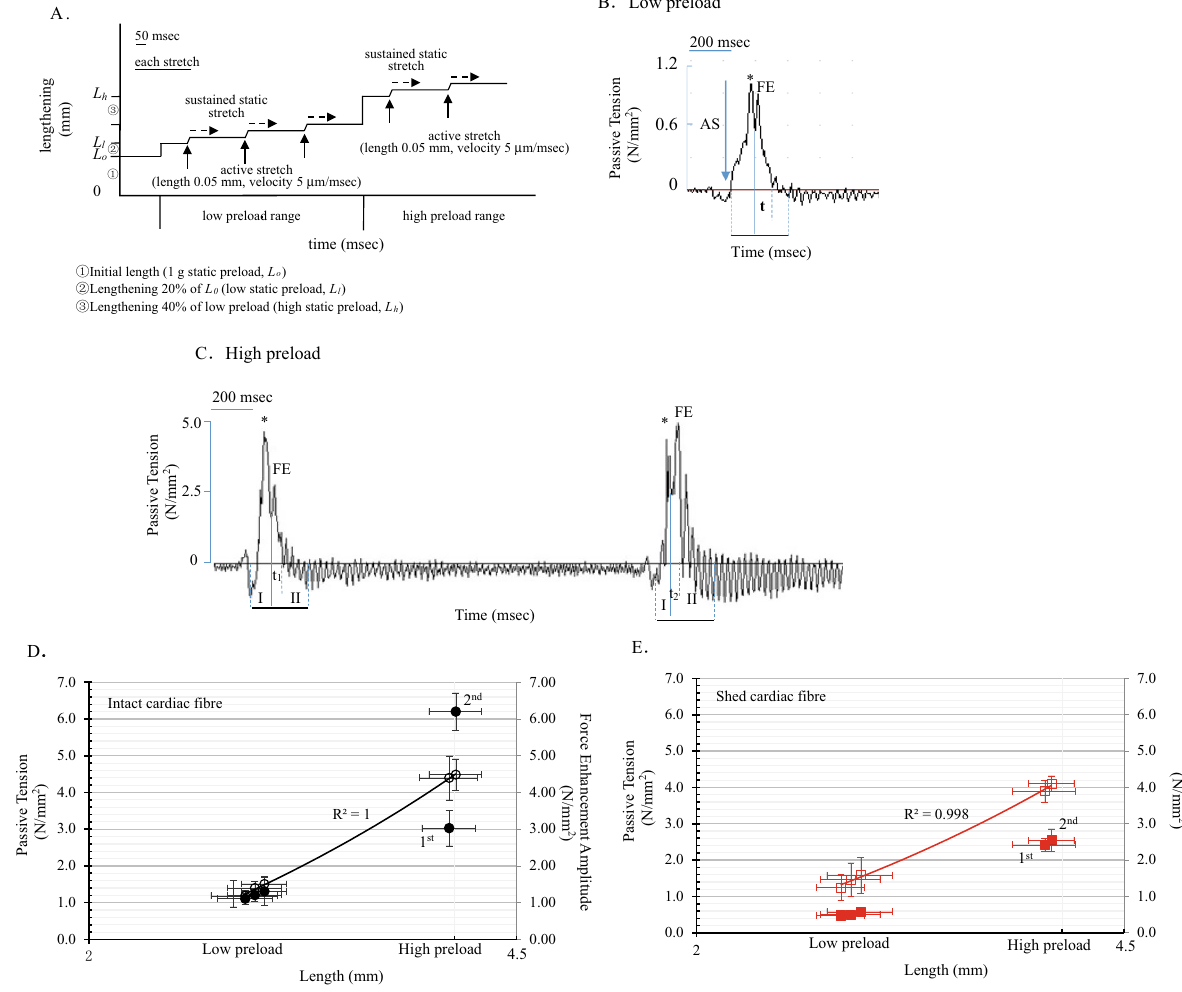
Figure 2. Real-time occurrence of force enhancement in excessive preload cardiac muscle fibres. ( A ) Sketched schematic of stretching cardiac papillary muscle fibres. The fibres were first lengthened to obtain a 1 g initial preload ( ① in the y-axis, L o ). The fibres were further slowly lengthened to 20% of their initial preloaded length (lengthening ② in y-axis), and this length was defined as the low preload ( L l ). The active stretch was operated under L l . After the low preload tests, the fibres further slowly lengthened to 40% of the final lengthening ( ③ in y-axis) to obtain the high preload ( L h ). The fibres were actively stretched twice under L h . The dotted line with the arrow indicates that the fibre tolerated sustained static stretch. ( B ) The myograph of stretches in cardiac fibre. When the fibre bears L l , an active stretch induces an increase in passive tension (AS and on time scale I; *, peak of passive tension, PT max ). Subsequently, a force enhancement occurred (FE, peak of force enhancement; t, force enhancement prolonging time). The fibre tolerated sustained static stretching during this period (II, the attenuation of passive tension). EF amplitude (A FE ) normally did not surpass its PT max . The stretch repeated three times under the L l condition. ( C ) In L h cardiac fibre, the 1st and 2nd A FE dramatically increased, furthermore the 2nd A FE significantly surpassed its PT max . ( D ) PT max presented a perfect linear correlation throughout preload range in intact cardiac fibres (R 2 = 0.99, n = 10). The A FE significantly increased in L h cardiac fibres. Furthermore, the 2nd A FE surpassed its PT max . The erratic occurrence of force enhancement was observed in high preload cardiac fibre. ( E ) PT max presented a perfect linear correlation throughout preload range in shed cardiac fibres (R 2 = 0.99, n = 10). The A FE reduced in L h cardiac fibres. No surpassing of its PT max The force enhancement tension-time integral TTI in cardiac muscle fibres. TTI in intact muscle fibres. In the low preload range, the force enhancement tension-time integral TTI were 22.01 ± 0.73 N/mm 2 s, 24.04 ± 1.21 N/mm 2 s and 26.88 ± 1.48 N/mm 2 s in the 1st, 2nd and 3rd stretches, respectively. In high preload range, TTI was 27.45 ± 0.84 N/mm 2 s and 25.90 ± 0.95 N/mm 2 s in 1st and 2nd stretch respectively; in fact, TTI in 2nd increased 9.22% of 1st in low preload range, but it reduced 5.65% of 1st in high preload range (Fig. 4A, solid dots tagged as 1st and 2nd in high preload range, *** means significant reduced, p < 0.01). The force enhancement extended time (t) was prolonged in the low preload range, t 2 prolonged 7.10% of t 1 ; however t 2 reduced 7.60% of t 1 in high range (Fig. 4B, solid dots tagged 1st and 2nd). In high preload range,